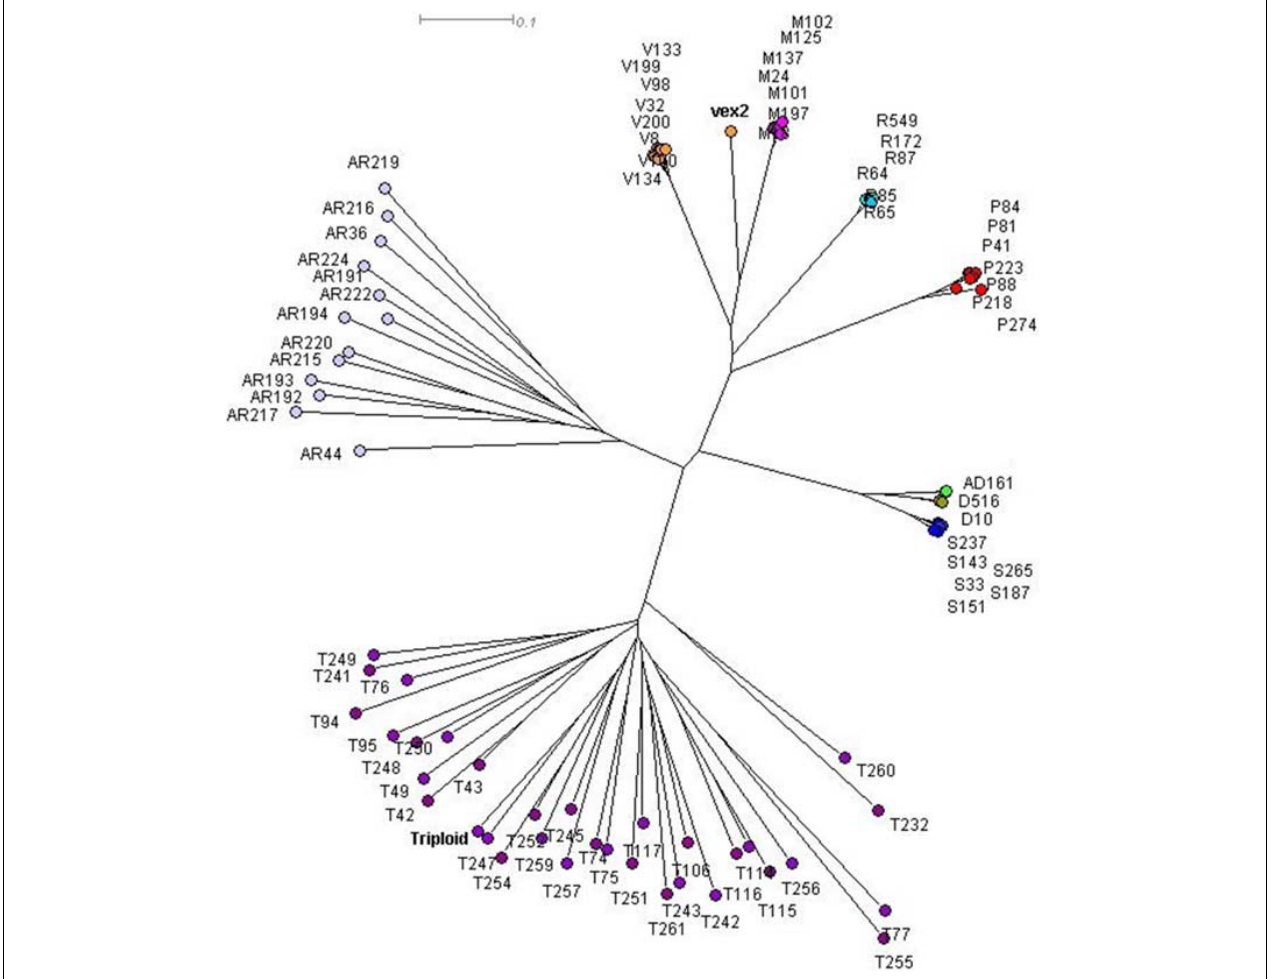
FIGURE 4 | Neighbor-joining (NJ) tree of 80 Sorbus MLGs constructed using a Bruvo distance matrix in SplitsTree 4.0. Sample colors correspond to those given in Figure 3 . vex2 indicates the second S. vexans clone. The triploid S. torminalis individual is indicated.